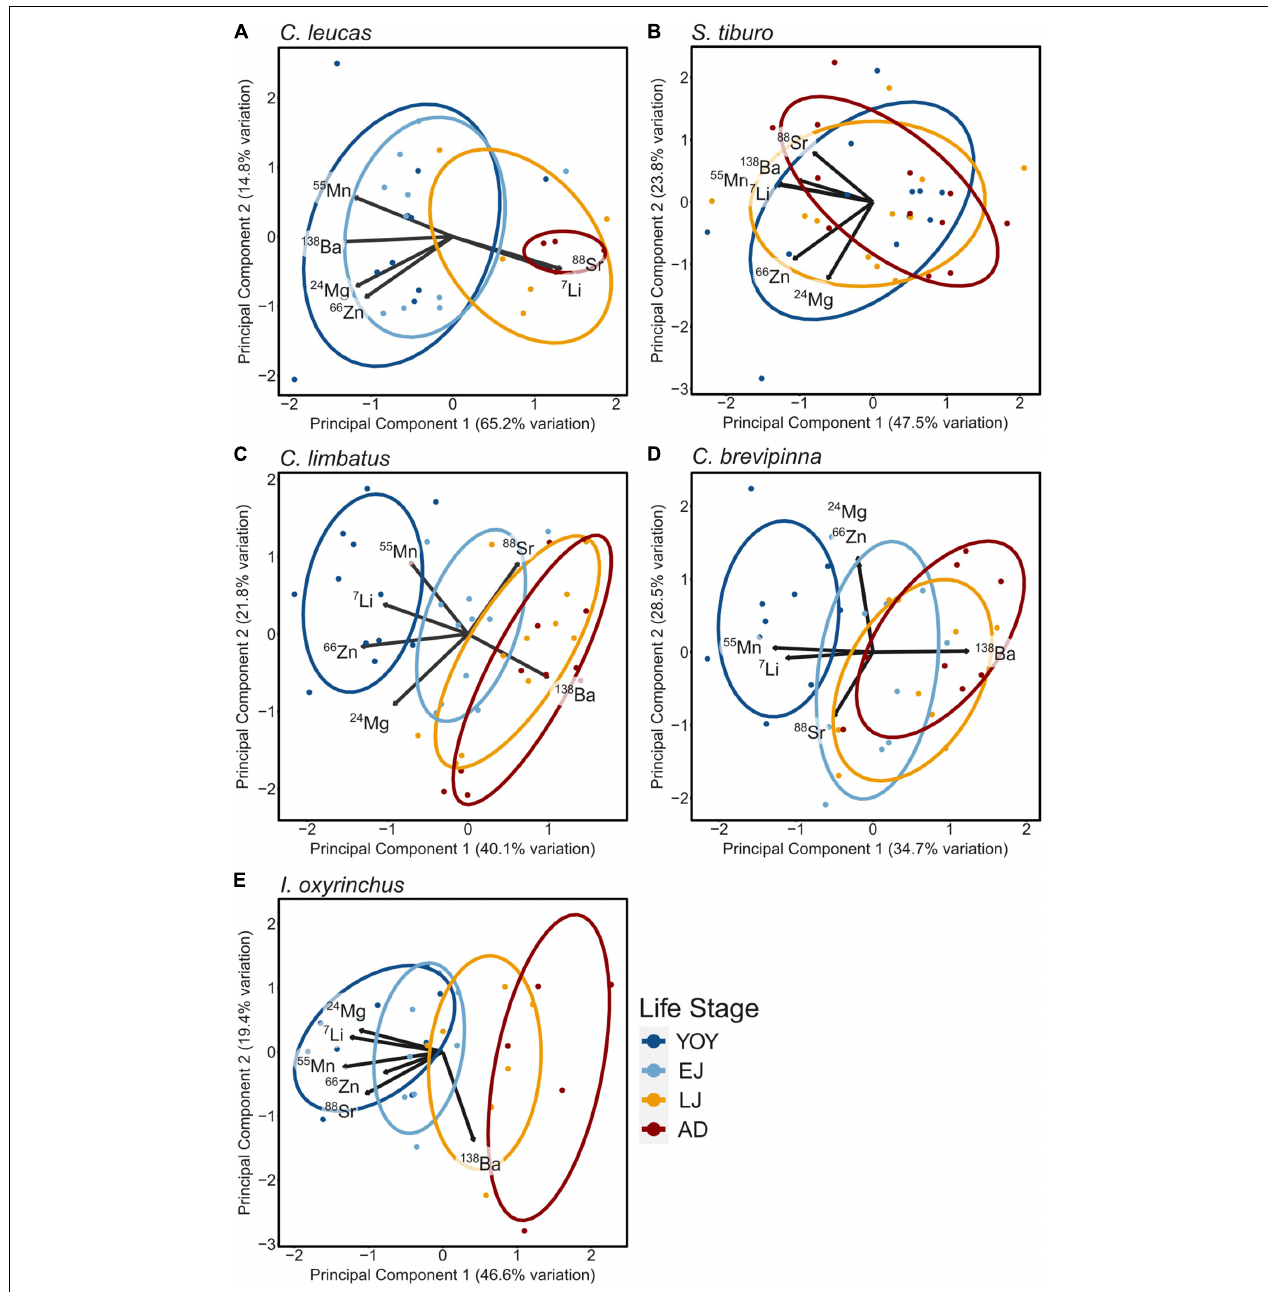
FIGURE 4 | Visualized principal component analysis for each species, with life stage (YOY, young-of-the-year; EJ, early juvenile; LJ, late juvenile; AD, adult) as the grouping factor (represented by color). Principal components 1 and 2 are represented as the x and y axis, respectively, and the percent of total variation explained by each PC is listed. Loadings for each element are represented by black arrows, and are labeled per element.